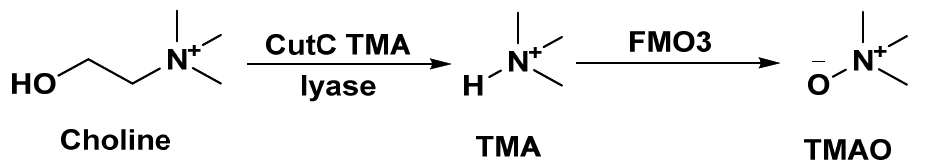
Figure 2. Two-step metabolic pathway for choline by CutC TMA lyase and FMO3 enzymes. Ab- Figure 2. Two ‐ step metabolic pathway for choline by CutC TMA lyase and FMO3 enzymes. Abbre ‐ breviations: CutC: trimethylamine-lyase; FMO3: monooxygenase 3; TMA: trimethylamine; TMAO: viations: CutC: trimethylamine ‐ lyase; FMO3: monooxygenase 3; TMA: trimethylamine; TMAO: tri ‐ trimethylamine N-oxide. methylamine N ‐ oxide.